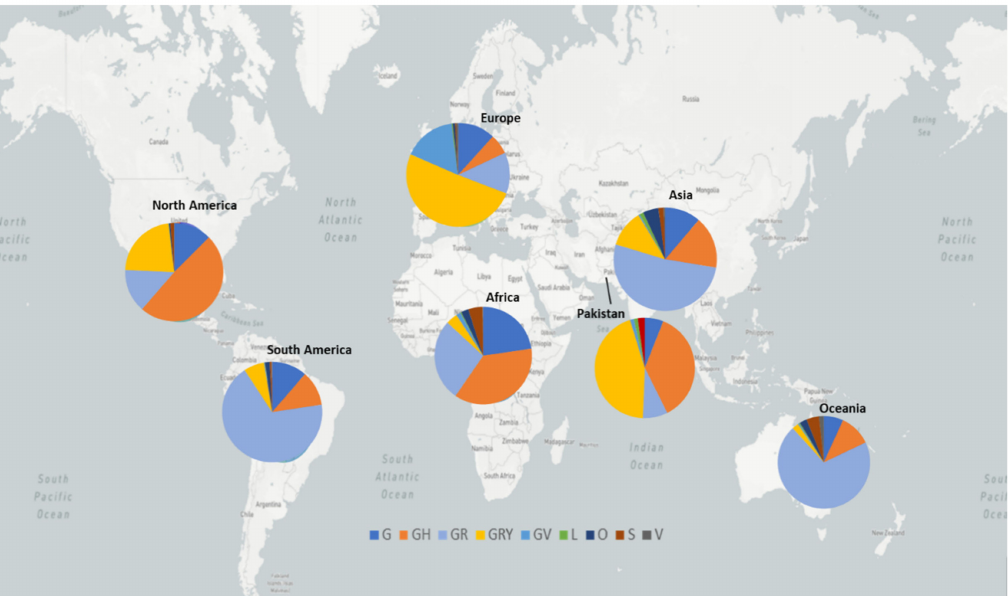
Figure 5. GISAID clades of SARS-COV-2 genome from global and Pakistani datasets. The map in the background is adopted from https://nextstrain.org/sars-cov-2/ accessed on 16 June 2021